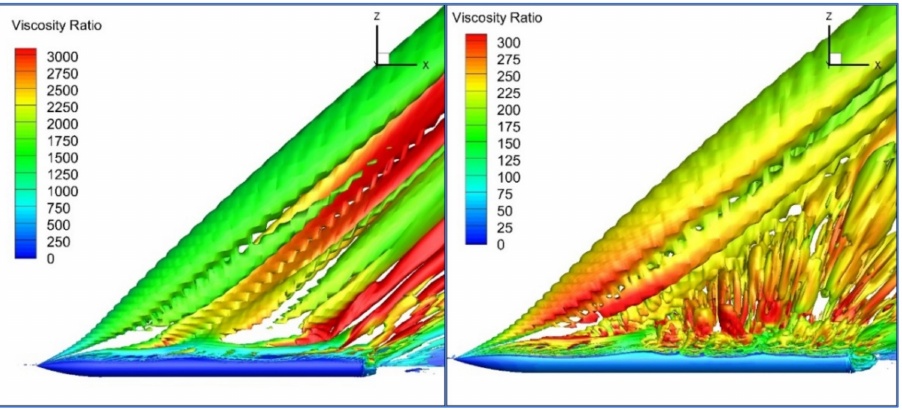
Figure 11. Iso surface of positive Q function (up to 5000) colored with turbulent viscosity ratio at Mach number Ma = 0.2, Reynolds number Re = 2 × 10 6 and angle of attack α = 45 degrees. ( Left ): k- ω SST-SAS model. ( Right ): ω -based RSM-SAS model. Grid